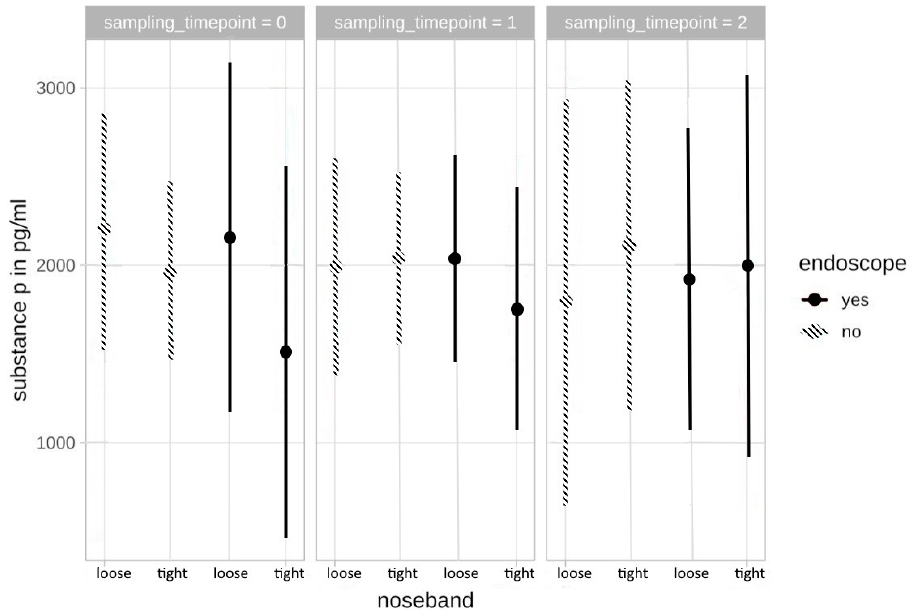
Figure 3. SP plasma concentrations in correlation with the different stress levels at t0–t2.